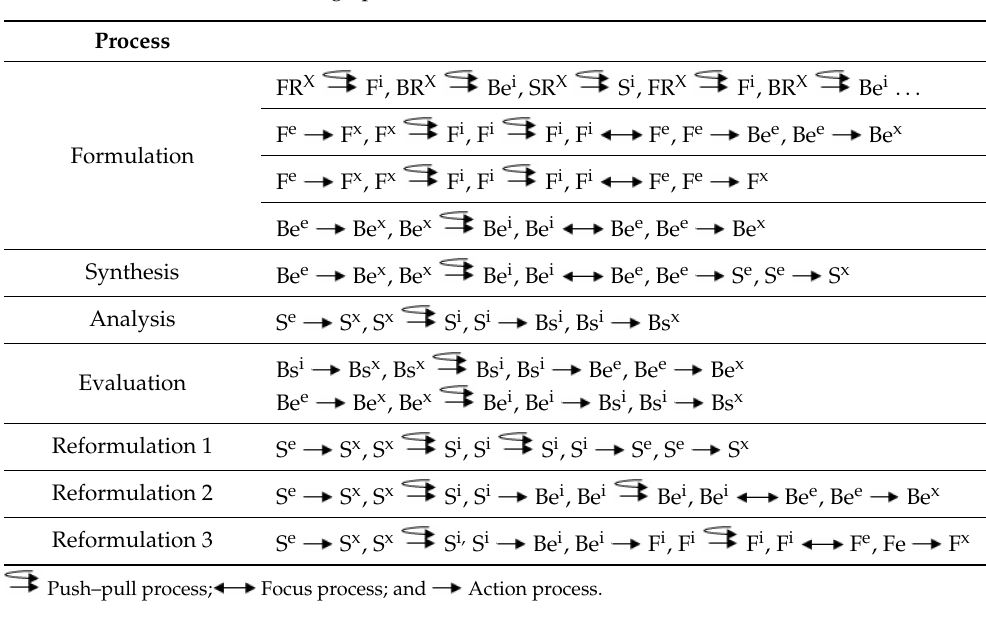
Table 2. The situated FBS co-design processes